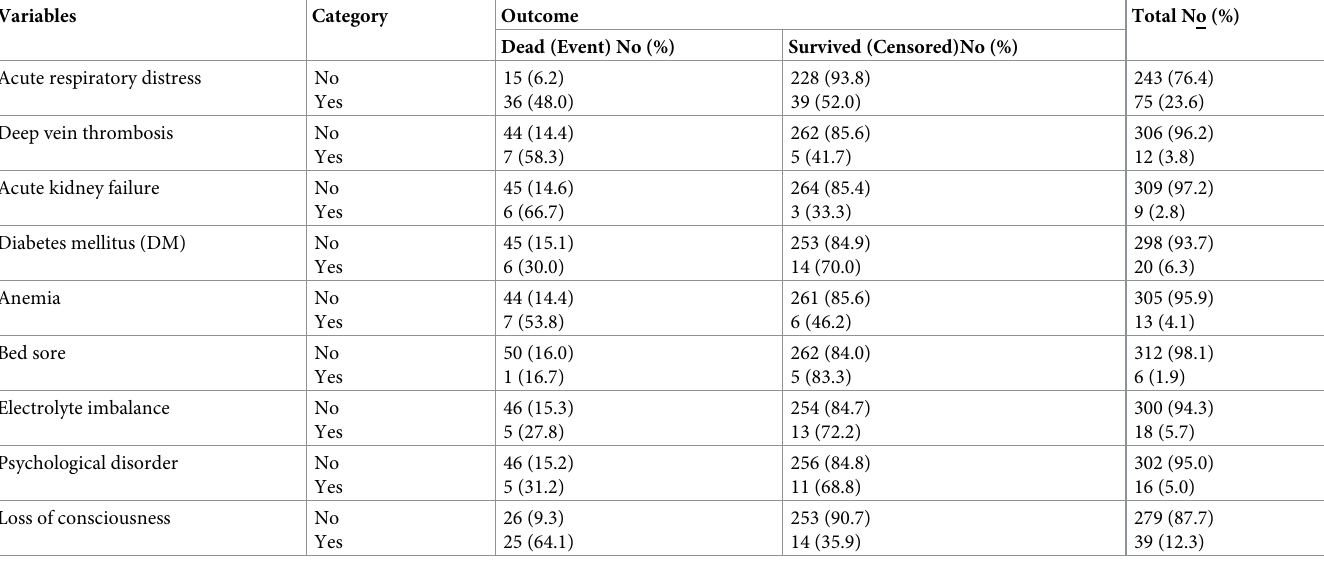
Table 4. Types of complications developed on patients admitted with severe COVID-19 cases in WURH treatment center, Western Ethiopia. Variables